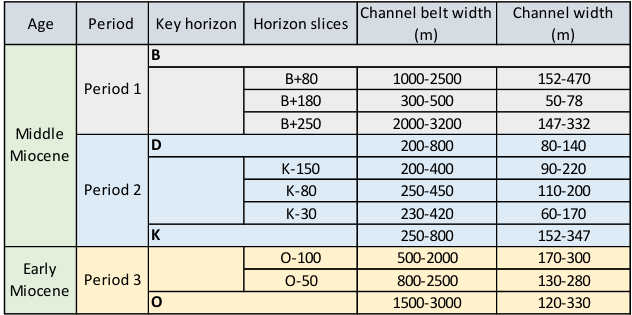
The horizon slices at O-100, O-50 and O typify the fluvial system in the central and eastern part of the area. Drilled wells in that region show the evidence of stacked channel sands. The fluvial system in period 3 interval has multiple channel sands, which are mostly north-south trending. The